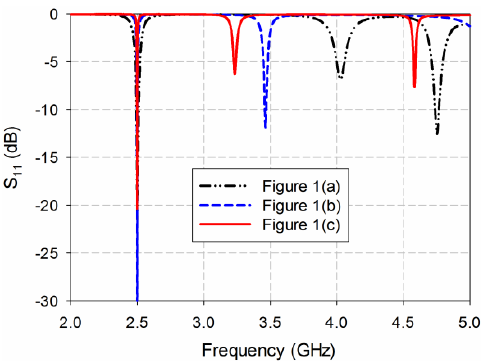
Figure 2. S 11 characteristics of the three MPSAs in Figure 1.